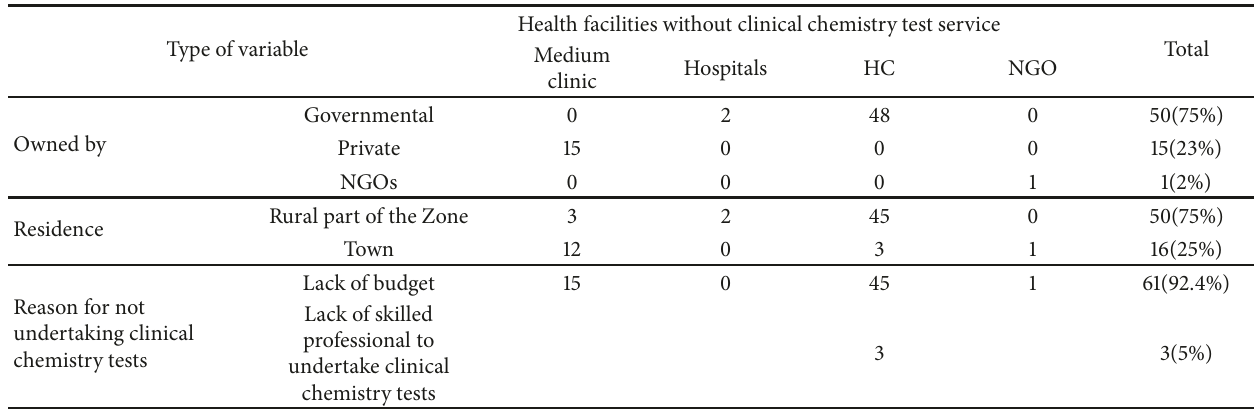
Table 1: Distribution of health facilities according to their ownership, location, and reason for not undertaking clinical chemistry